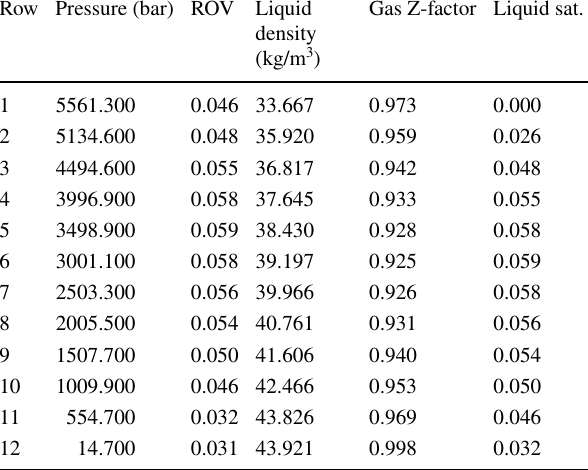
Table 3 CVD test on the reservoir fluid